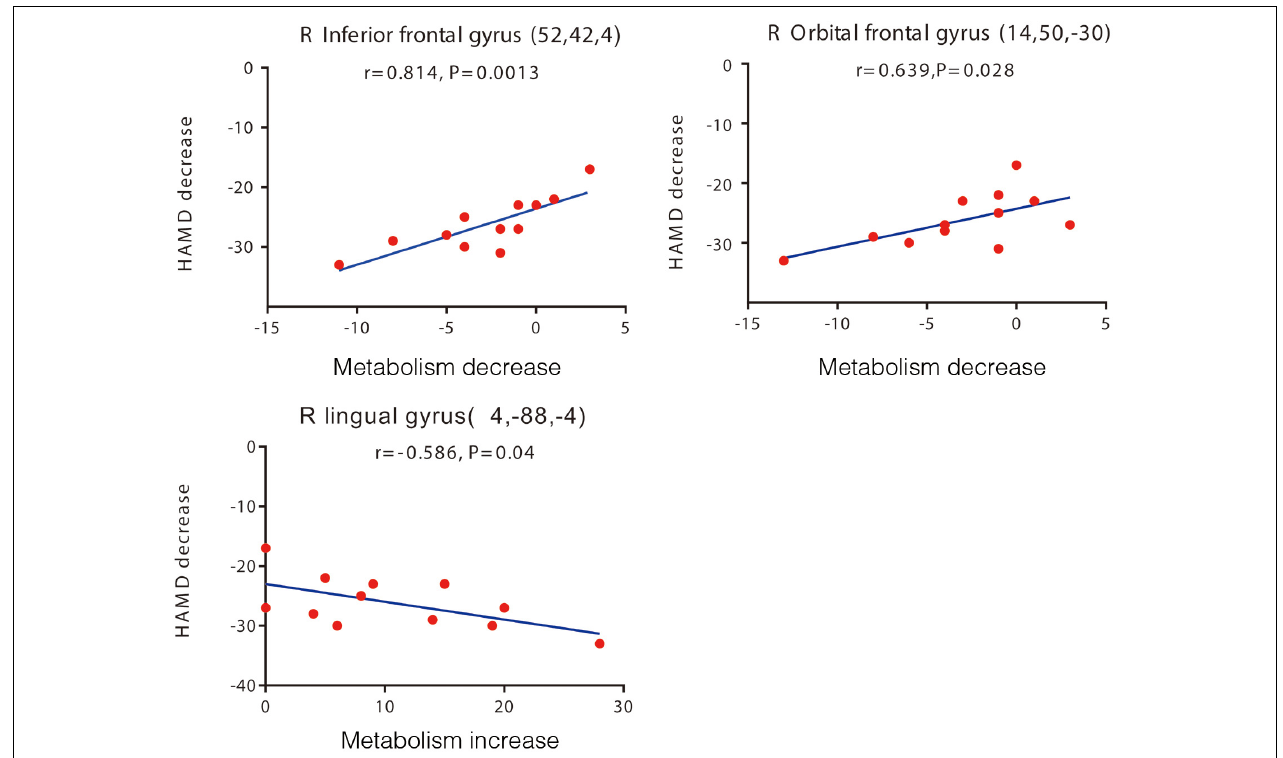
FIGURE 3 | Brain regions with significant correlations between changes in the HAMD-24 score and changes in glucose metabolism after STN-DBS. Decreased HAMD-24 scores are correlated with decreased metabolism in the right inferior frontal gyrus, right orbital frontal gyrus (upper two panels), and with increased metabolism in the right lingual gyrus post-operation (lower panel). Each volume of interest peak coordinates is in parentheses in each panel. The threshold of the SPM5 map (Wellcome Department of Imaging Neuroscience, Institute of Neurology, London, United Kingdom) is t = 3.14 ( p < 0.01). The map is superimposed on a standard magnetic resonance imaging brain template. The y-axis in this figure is the pre-operative and post-operative difference of HAMD score, and the x-axis is the pre-operative and post-operative difference of relative metabolic rate. HAMD-24, 24-item Hamilton Depression Rating Scale; STN-DBS, subthalamic nucleus deep brain